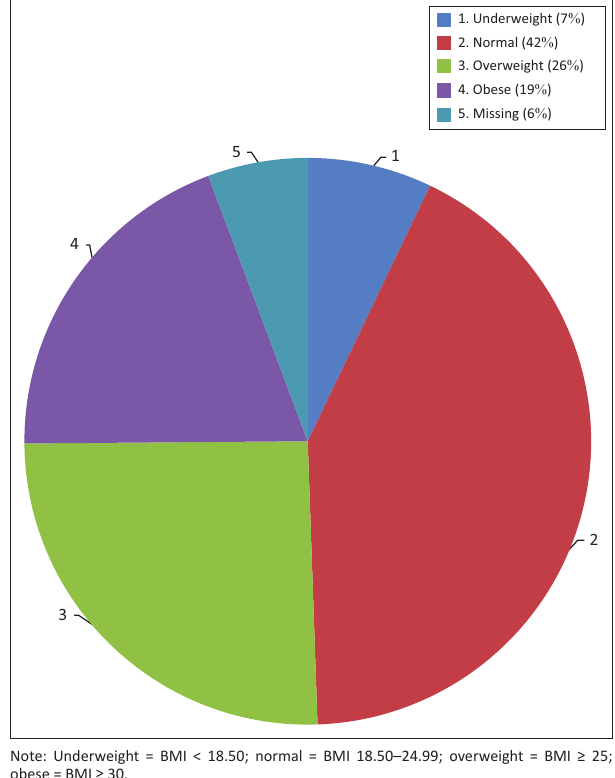
FIGURE 1: Body mass index categories of 350 patients at